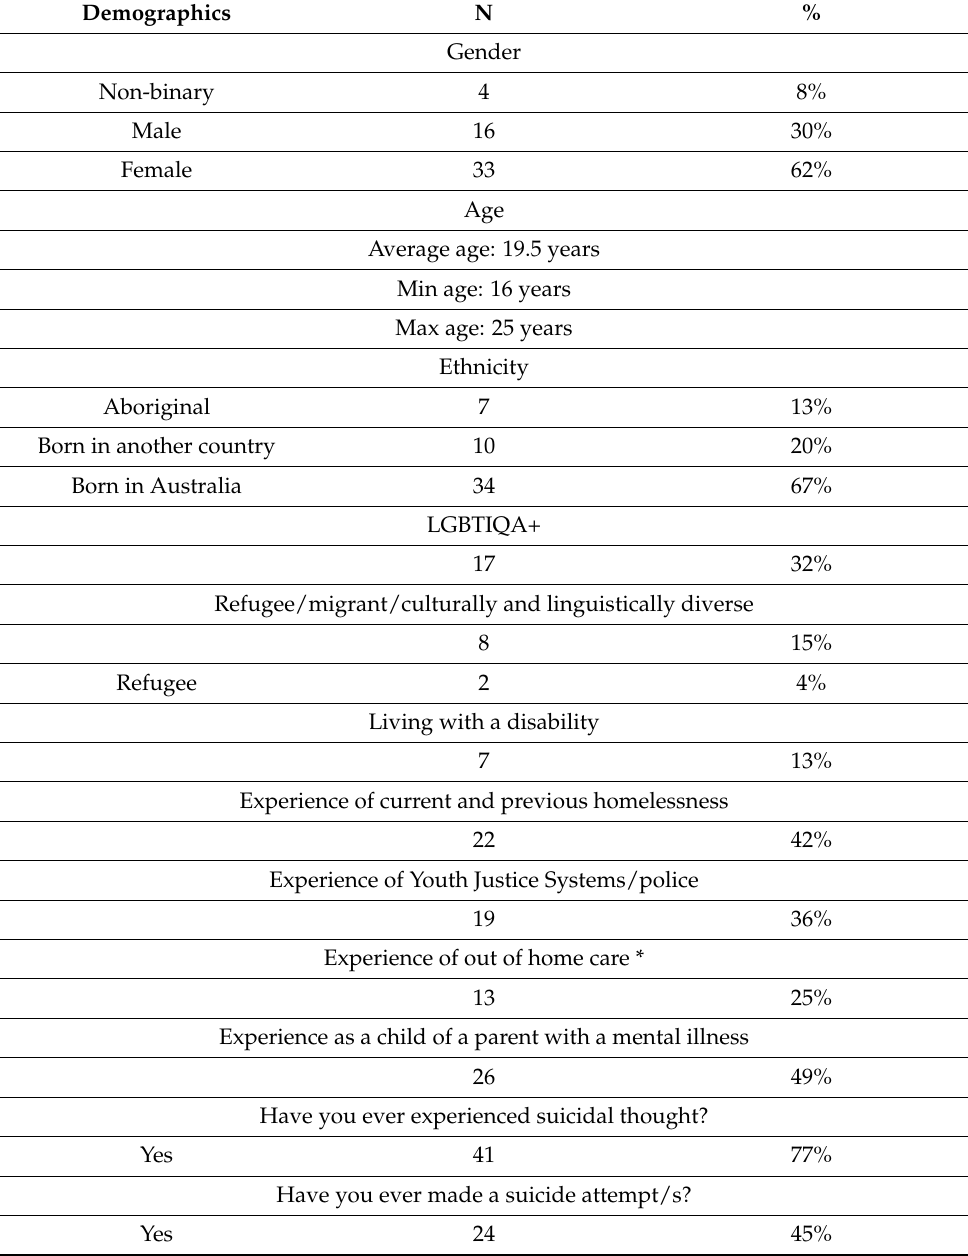
Table 1. Demographics and lived experiences of participants.